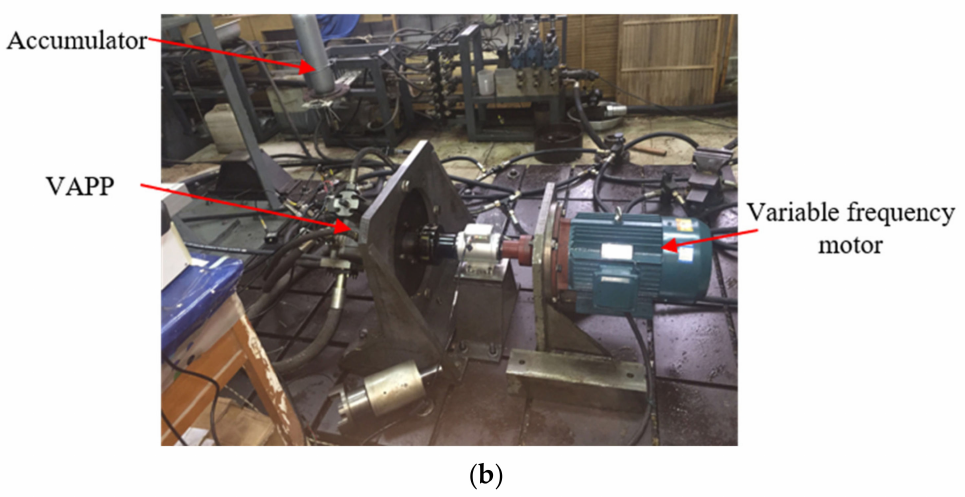
Figure 7. Main components of the test bench ( a , b ). During the test, the speed and direction of rotation of the motor are set unchanged. When working, the VAPP is driven by the motor, and DSpace sets the electro-hydraulic servo-valve signal to control the swash-plate inclination, as shown in Figure 8.